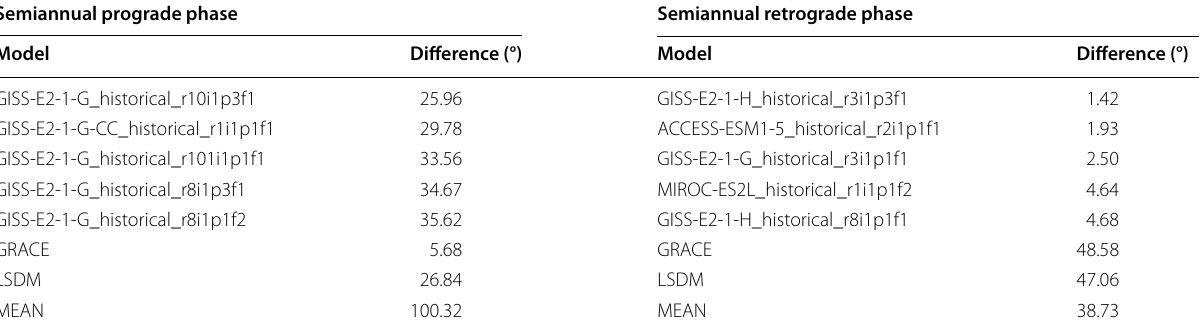
The results obtained from GRACE, LSDM, and MEAN model are also shown